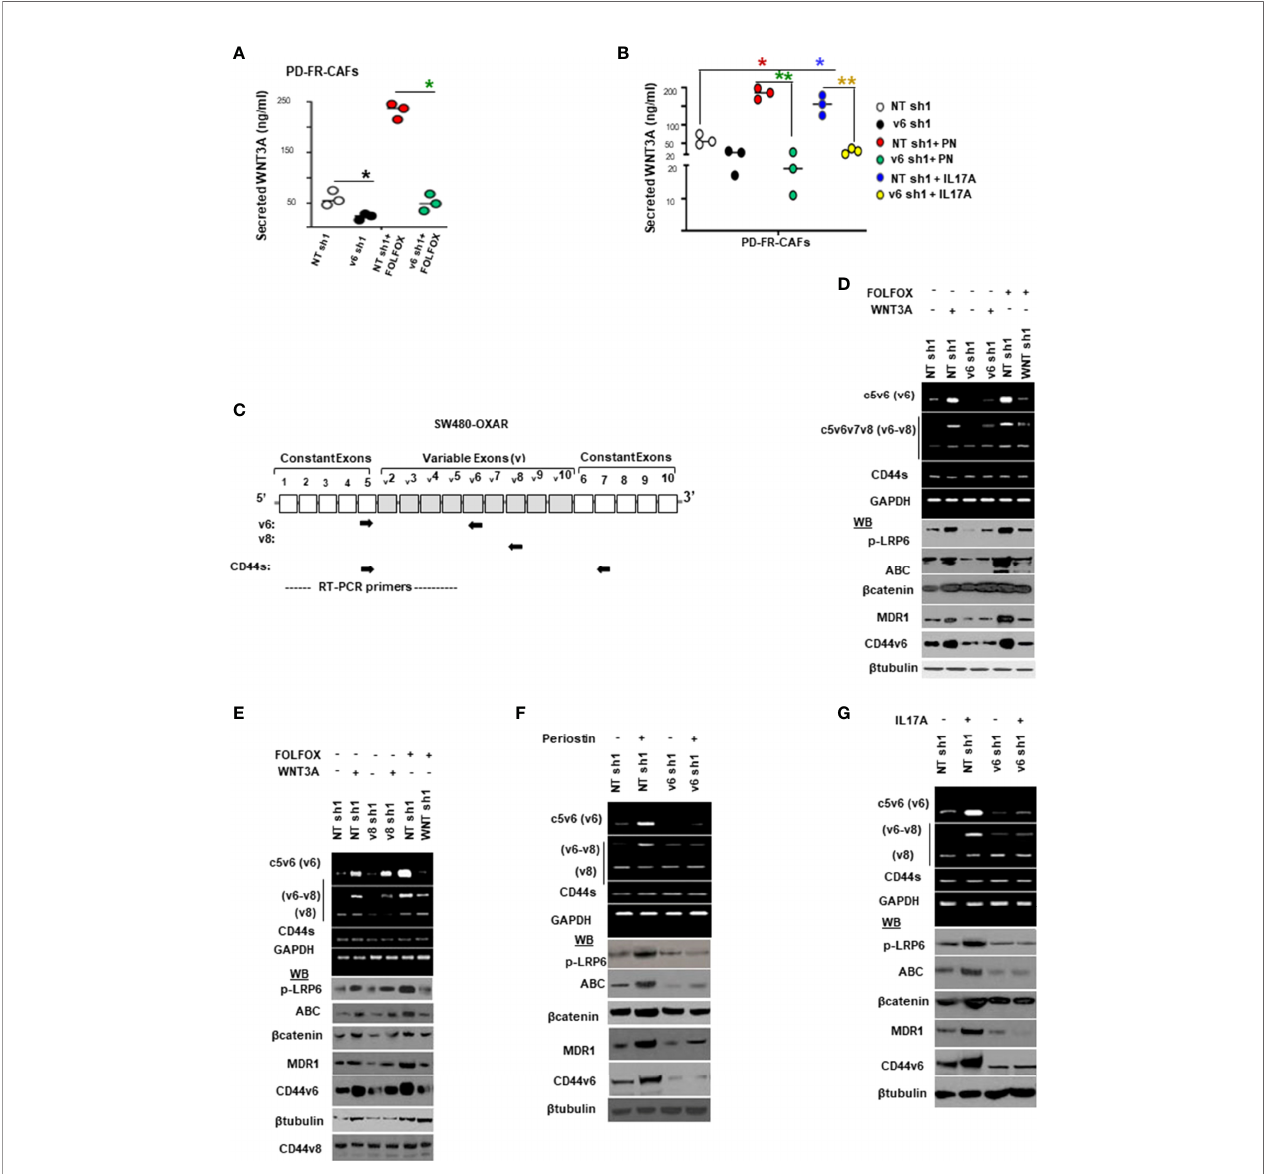
FIGURE 5 | FOLFOX induces CD44v6 expression, which is critically regulated by the WNT pathway stimulated by PN and/or IL17A. (A) , Con fi rmation of involvement of CD44v6 expression in regulating WNT3A production was assessed in PD-FR CAFs by examining the effects of blockade of CD44v6 using speci fi c shRNAs on 10 4 SW480-FR/ CAFs in the absence and presence of FOLFOX. The effects were evaluated by measuring secreted WNT3A in cultures by ELISA. (B) , Involvement of CD44v6 in regulating PN and IL17A induced WNT3A production was assessed in PD-FR CAFs by examining the effects of blockade of CD44v6 using speci fi c shRNAs in the absence and presence of PN or IL17A. The effects were evaluated by measuring secreted WNT3A in cultures by ELISA. (C) , Schematic illustration of the CD44 gene is shown. Both constitutive (C) and variable (v) exons are represented. The PCR primers used to amplify CD44 variable (v) and standard (s) isoforms are shown as black arrows. The primers for both the v6 and standard isoforms (CD44s) predominantly generate one PCR product [C5v6 (v6) for CD44v6, and C5C7 for CD44s], whereas the primers for the v8 variants amplify two splice variants C5v6v7v8 (v6-v8) and C5v8 (v8). These PCR products are depicted in panels (D – G) experiments. The primers for both the v6 and standard isoforms predominantly generate one PCR product [c5v6 (v6)], whereas the primers for the v8 variants amplify two splice variants C5v6v7v8 (v6-v8), and C5v8 (v8). (D, E) , WNT3A shRNA, or CD44v6 shRNA1 (D) , but not CD44v8 shRNA1 (E) Upper panels: Semi-quantitative RT-PCR analyses are shown for CD44 variants in SW480-OXAR SQ tumor cells transfected with NT sh, or v6 sh1 or WNT3A sh1 followed by WNT3A or FOLFOX stimulation for 12 hours. Lower panels: Western blot analyses are shown for p-LRP6, active b − catenin, total b − catenin, MDR1, CD44v6 or b -tubulin. (E) , Upper panels: Semi-quantitative RT-PCR analyses are shown for CD44 variants in SW480-OXAR SQ tumor cells transfected with NT sh, or v8sh1, or WNT3A sh1 followed by WNT3A or FOLFOX stimulation for 12 hours. Lower panels: Western blot analyses are shown for p-LRP6, active b − catenin, total b − catenin, MDR1, CD44v6 or b -tubulin. (F, G) , Upper panels: Semi-quantitative RT-PCR analyses are shown for CD44 variants in SW480-OXAR SQ tumor cells transfected with NT sh or v6 sh1 followed by PN or IL17A stimulation for 12 hours. Lower panels: Western blot analyses are shown for p-LRP6 (S1490), active b − catenin, total b − catenin, MDR1, CD44v6 or b -tubulin. Data in A, B, represent means ± SD; n = 3 – 6 independent replicates in three independent experiments. (A) , *p < 0.05 was considered signi fi cant, inhibition of WNT3A secretion in v6 shRNA1 groups compared to NT shRNA1 controls. (B) , *p < 0.05, **p < 0.01 were considered signi fi cant, Inhibition of WNT3A secretion in v6 shRNA1 +PN and v6 shRNA1 +IL17A groups compared to NT shRNA1 controls. All Western blots and semi quantitative RT-PCR data are representative of three